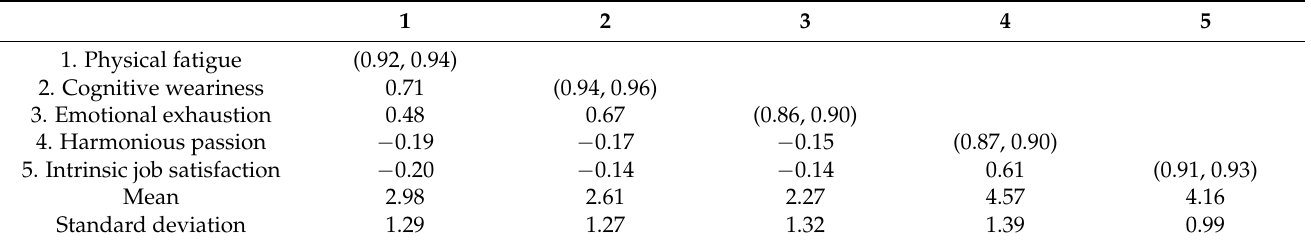
Table 1. Descriptive statistics and correlations ( n = 748).